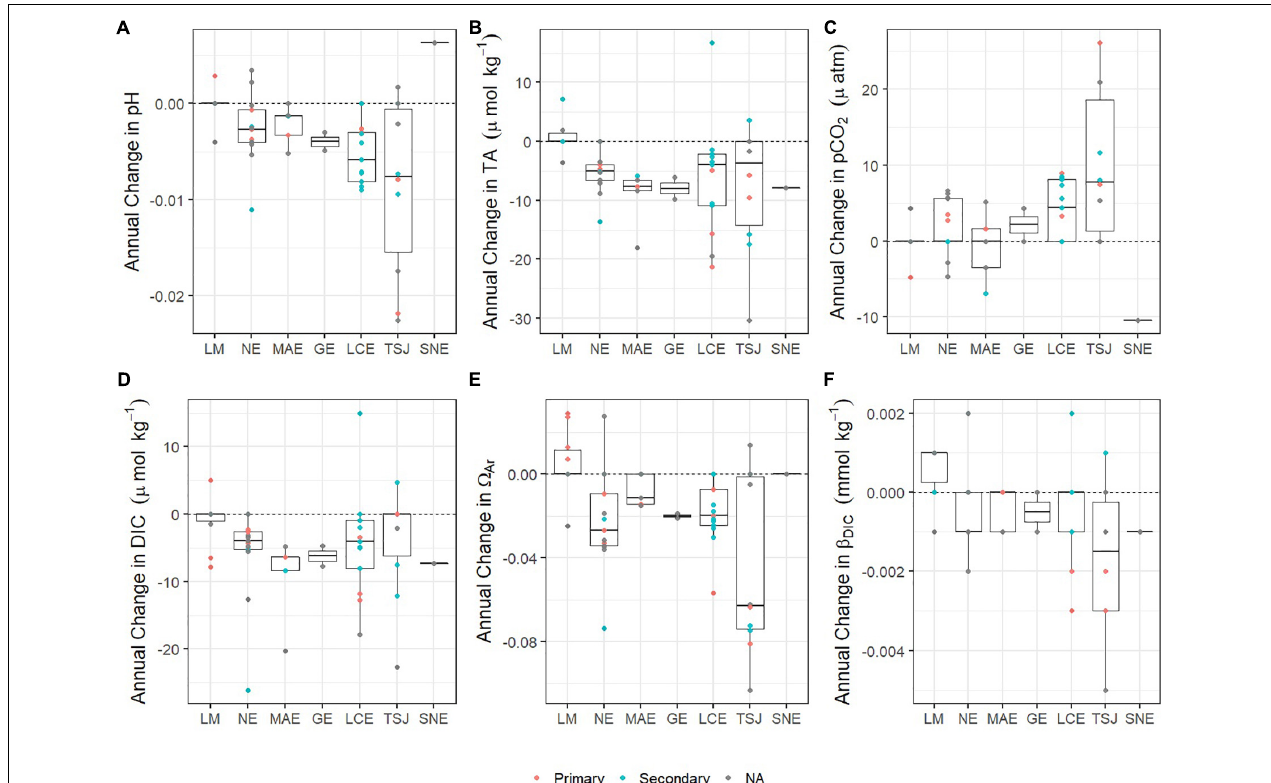
FIGURE 4 | Boxplots of the annual rate of change of carbonate system parameters [ (A) pH, (B) TA, (C) p CO 2 , (D) DIC, (E) (cid:127) Ar , and (F) β DIC ] at stations within each estuary. Estuaries are listed from south (LM) to north (SNE). Point data showing the rate of change at each station are colored to represent the station classification as within a primary bay (orange), secondary bay (blue). Data with not primary/secondary classification is shown in gray.